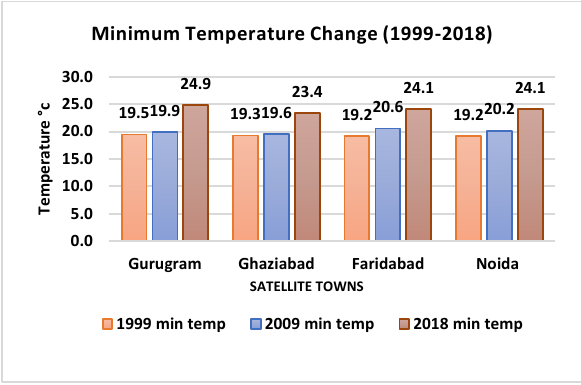
Figure 8. Change in Minimum temperature of Towns